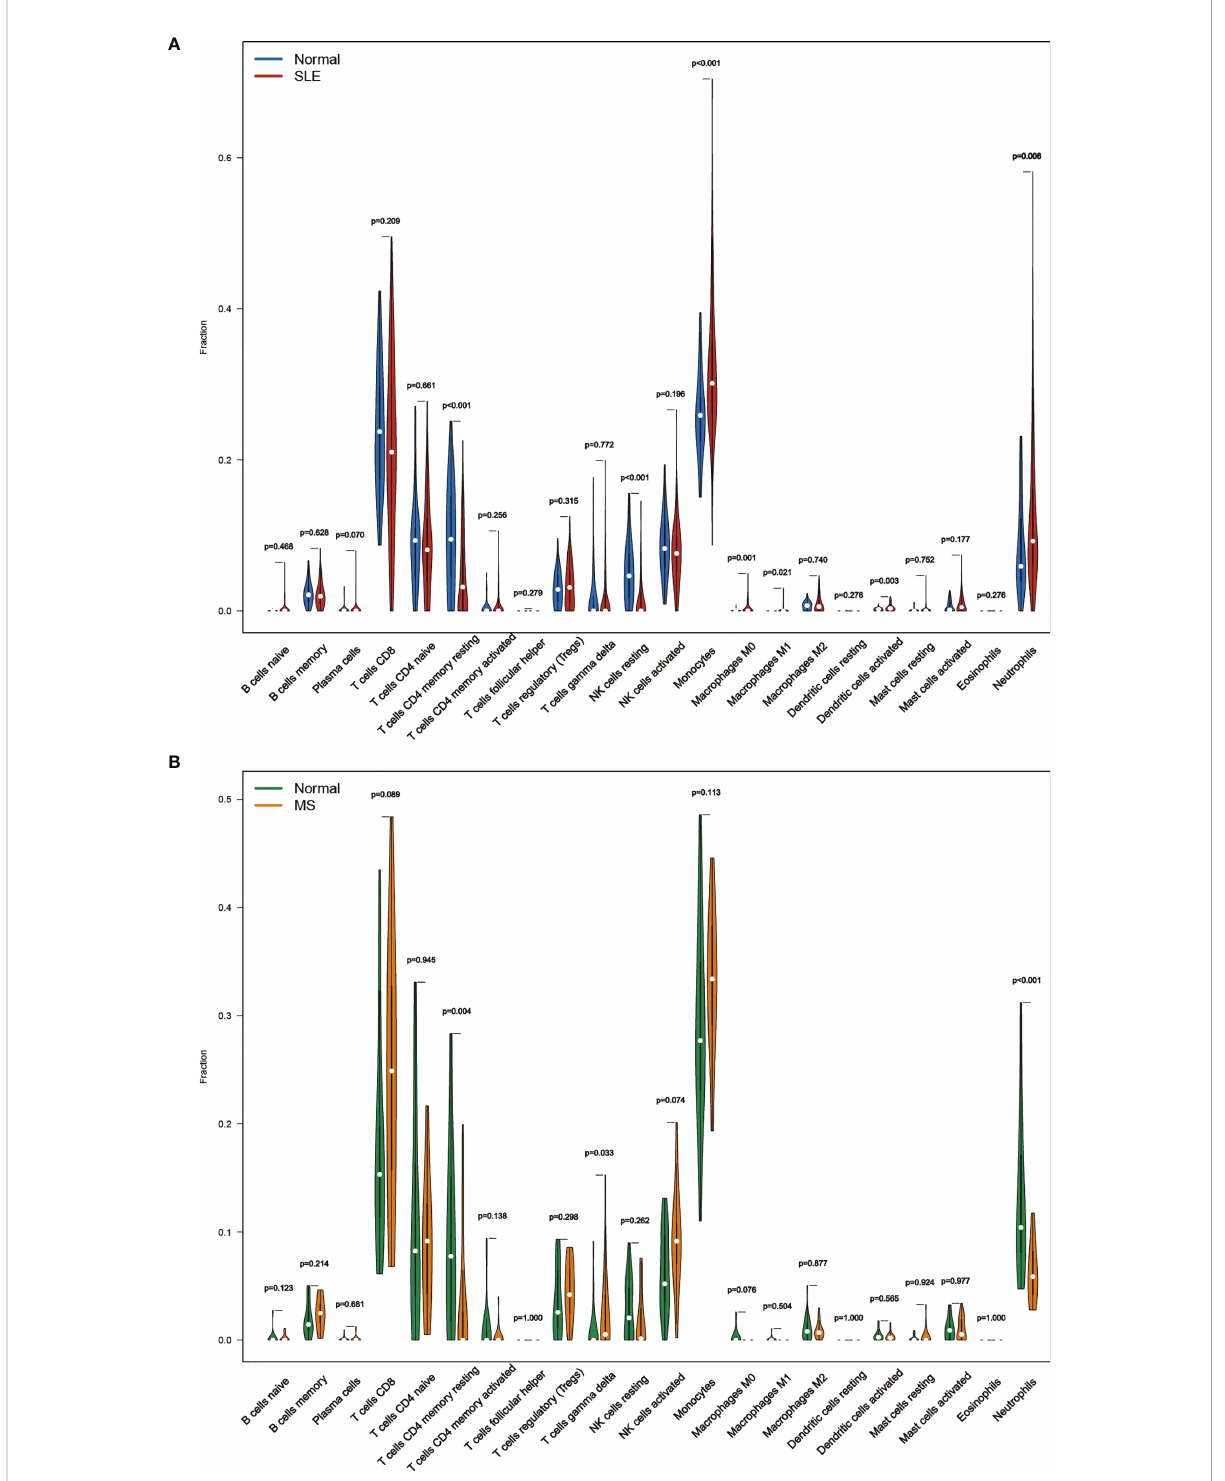
FIGURE 7 (A) The composition of the immune cell in fi ltrate in SLE. (B) The composition of the immune cell in fi ltrates in